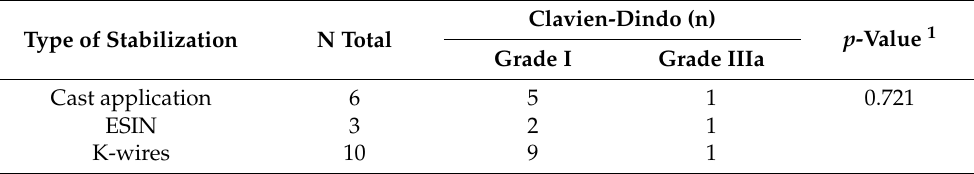
Table 5. Complications graded according to Clavien-Dindo classification by type of stabilization